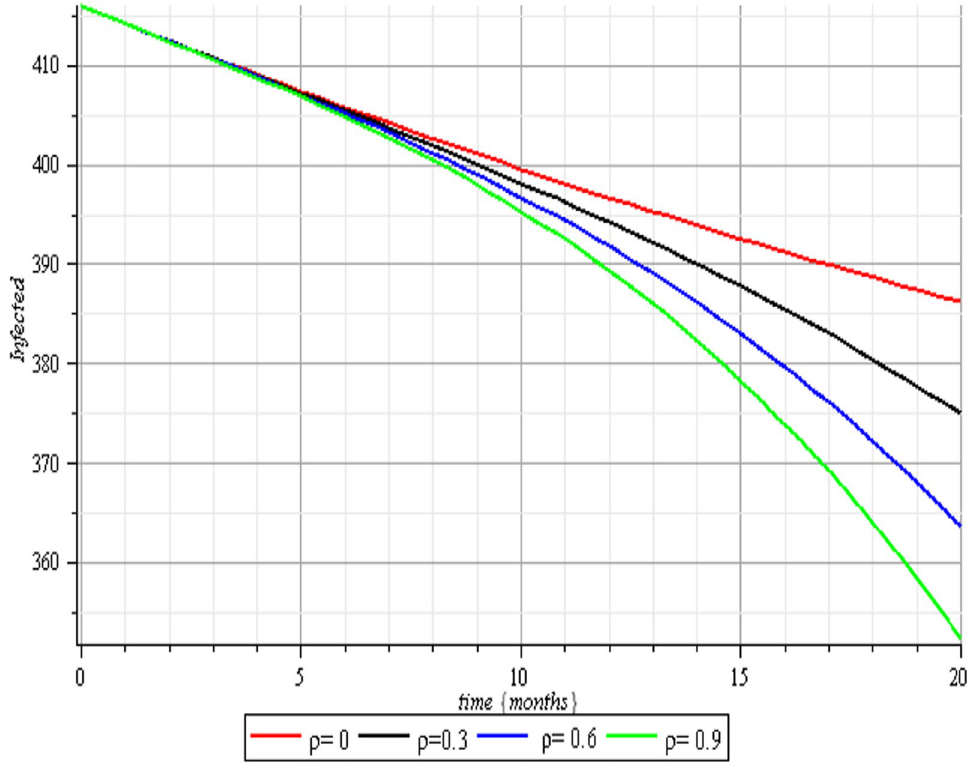
Fig. 9 Vaccination effects on the infected